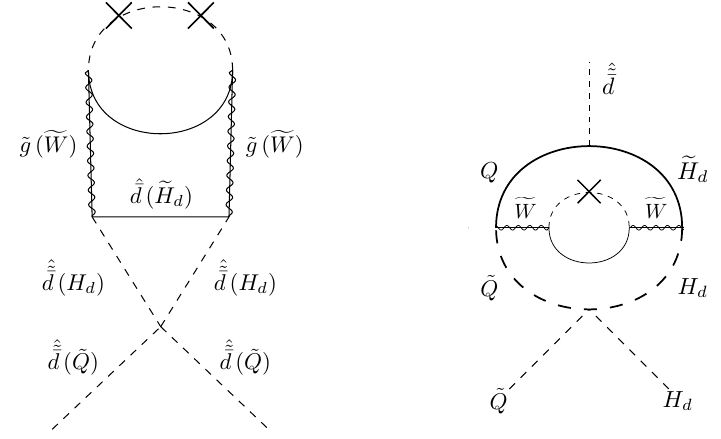
(left) and the A -parameter A ˆ d (right) induced ˆ˜¯ d, ˜ Q